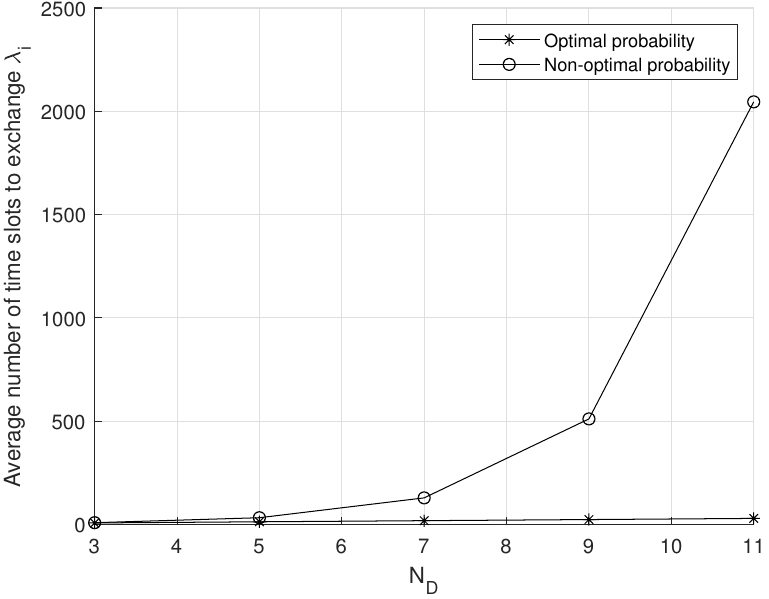
Figure 4. Average number of time slots to exchange λ i